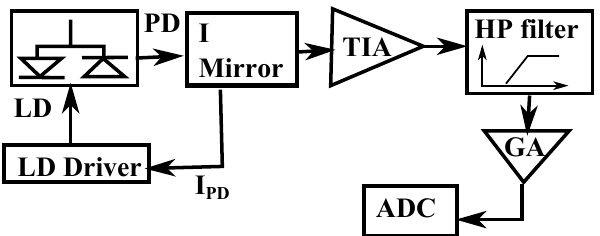
Electronic scheme of the mechanically-modulated OFI analogue acquisition and preconditioning stage. The PD current is passed through a current mirror (I mirror) to prevent loading effects on the transimpedance amplifier stage